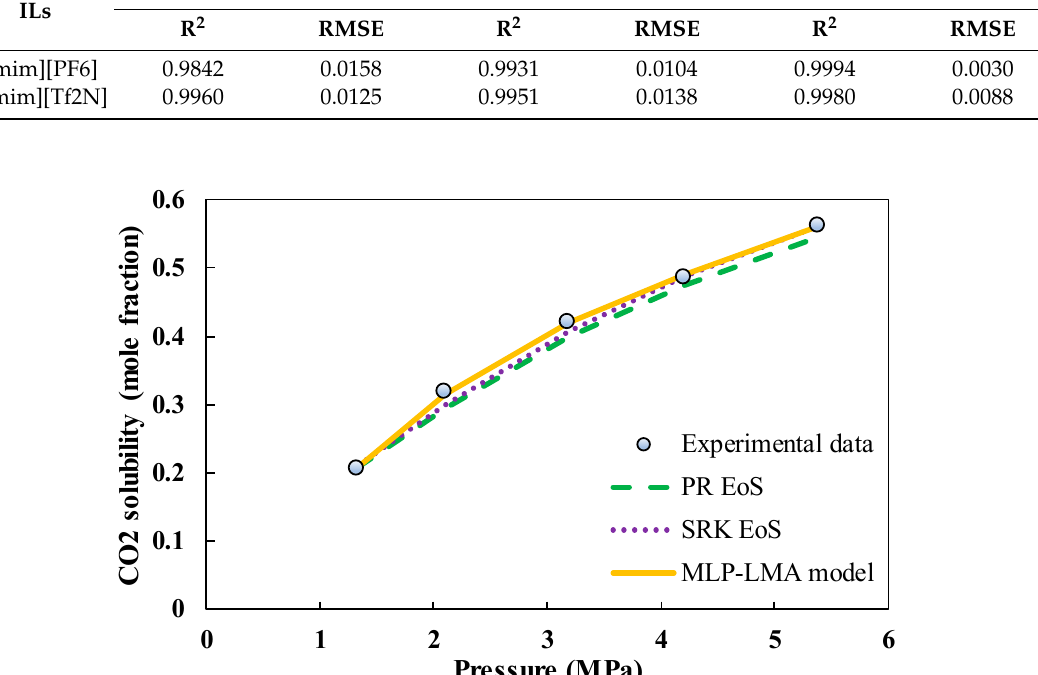
Figure 4. Comparison of Peng–Robinson (PR) and Soave–Redlich–Kwong equations of state (SRK EoS), and MLP-LMA model for prediction of CO 2 solubility in [bmim][PF6] at T = 298.15 K.